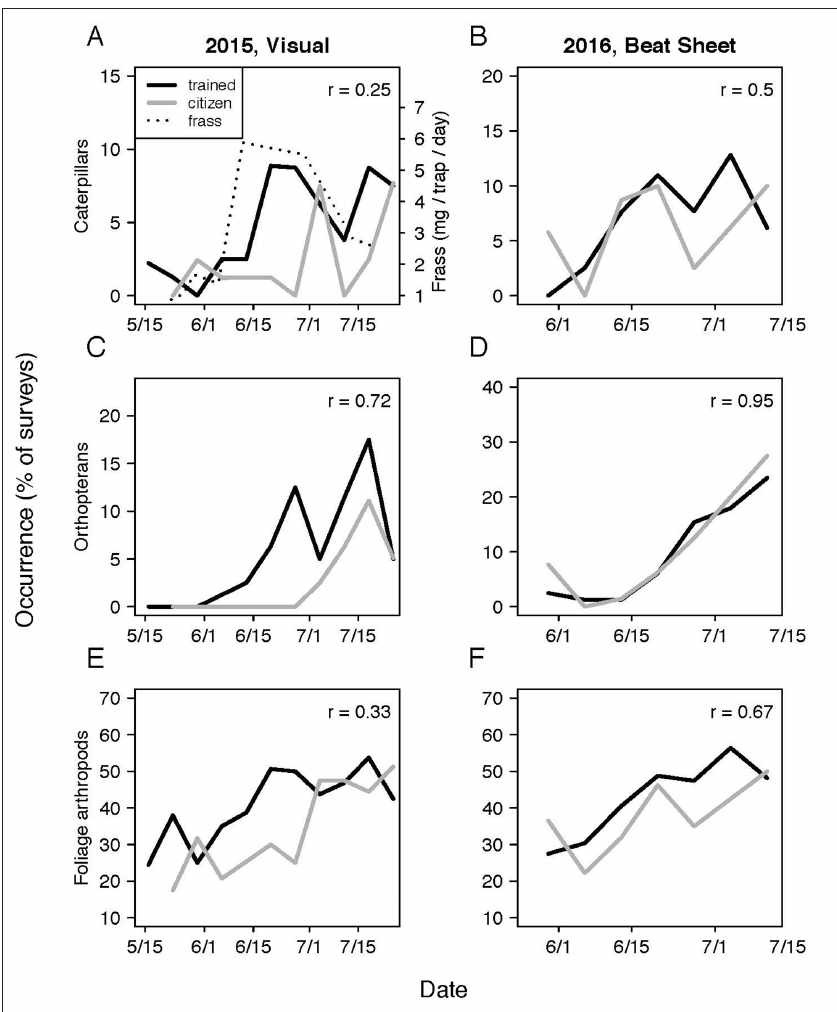
Figure 5: Seasonal phenology in occurrence at Prairie Ridge Ecostation of (a, b) caterpillars, (c, d) orthopterans, and (e, f) a multi-group category including caterpillars, orthopterans, beetles, spiders, leafhoppers, and true bugs based on visual surveys (a, c, e) and beat sheet surveys (b, d, f). Pearson’s correlation coefficient between weekly esti- mates collected by citizen scientists (light gray) and trained scientists (black) given in the top right. Caterpillar frass phenology in 2015 is shown for comparison in